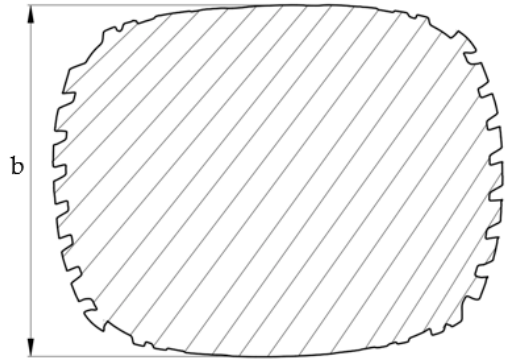
Figure 3. Horizontal cross-section with dimension b (width of tire profile).